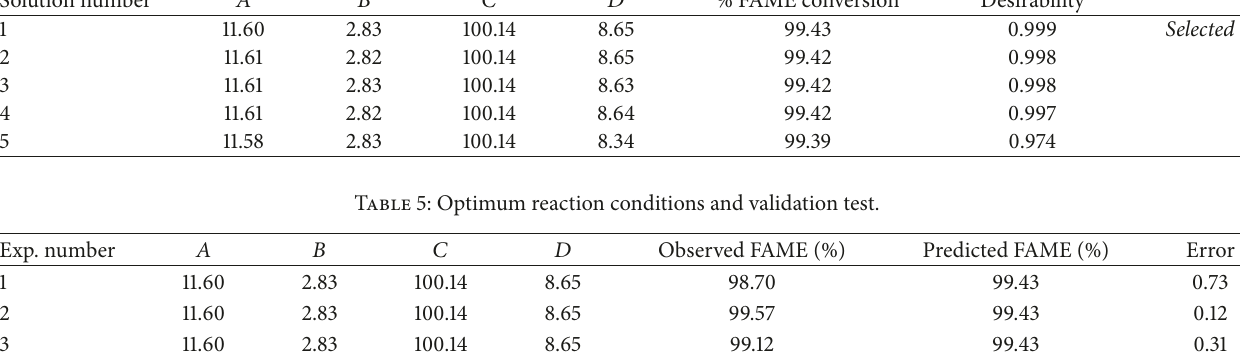
Table 6: Optimum conditions using Ca(OCH 3 ) 2 with and without THF as cosolvent for WCO biodiesel production.